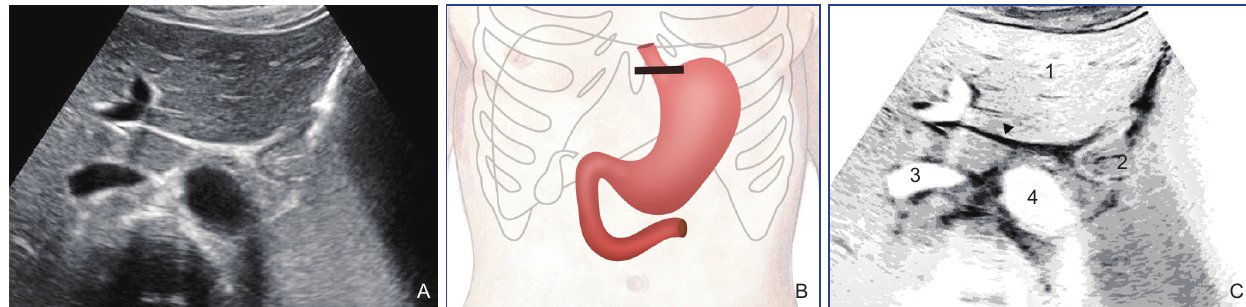
A B C Figure 2 Ultrasonic images of short axis section of cardia and scanning schematic diagram of section (scanning under xiphoid process). A, Ultrasound image; B, Scan the schematic diagram; C, Ultrasound schematic diagram (1, Left lobe of liver; 2, Cardia; Inferior vena cava; 3, Abdominal aorta; 4, Ligamentum laceration of hepatic vein)